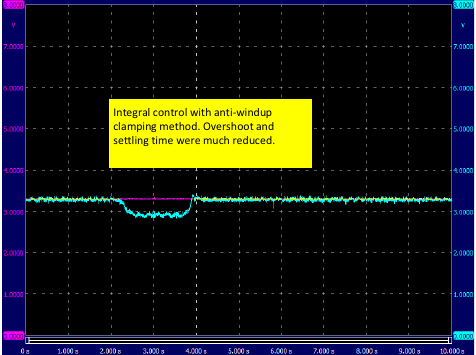
Fig. 10. Tachometer signal in the fourth